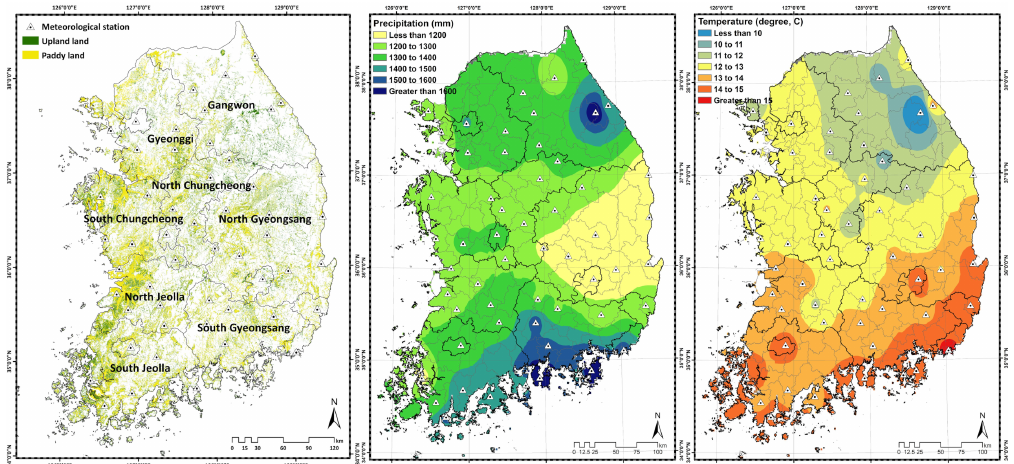
Figure2. Locationsofmeteorologicalstationsandlandcovermap(MinistryofEnvironment), andspatial distribution map of annual average precipitation and annual average temperature from 1981 to